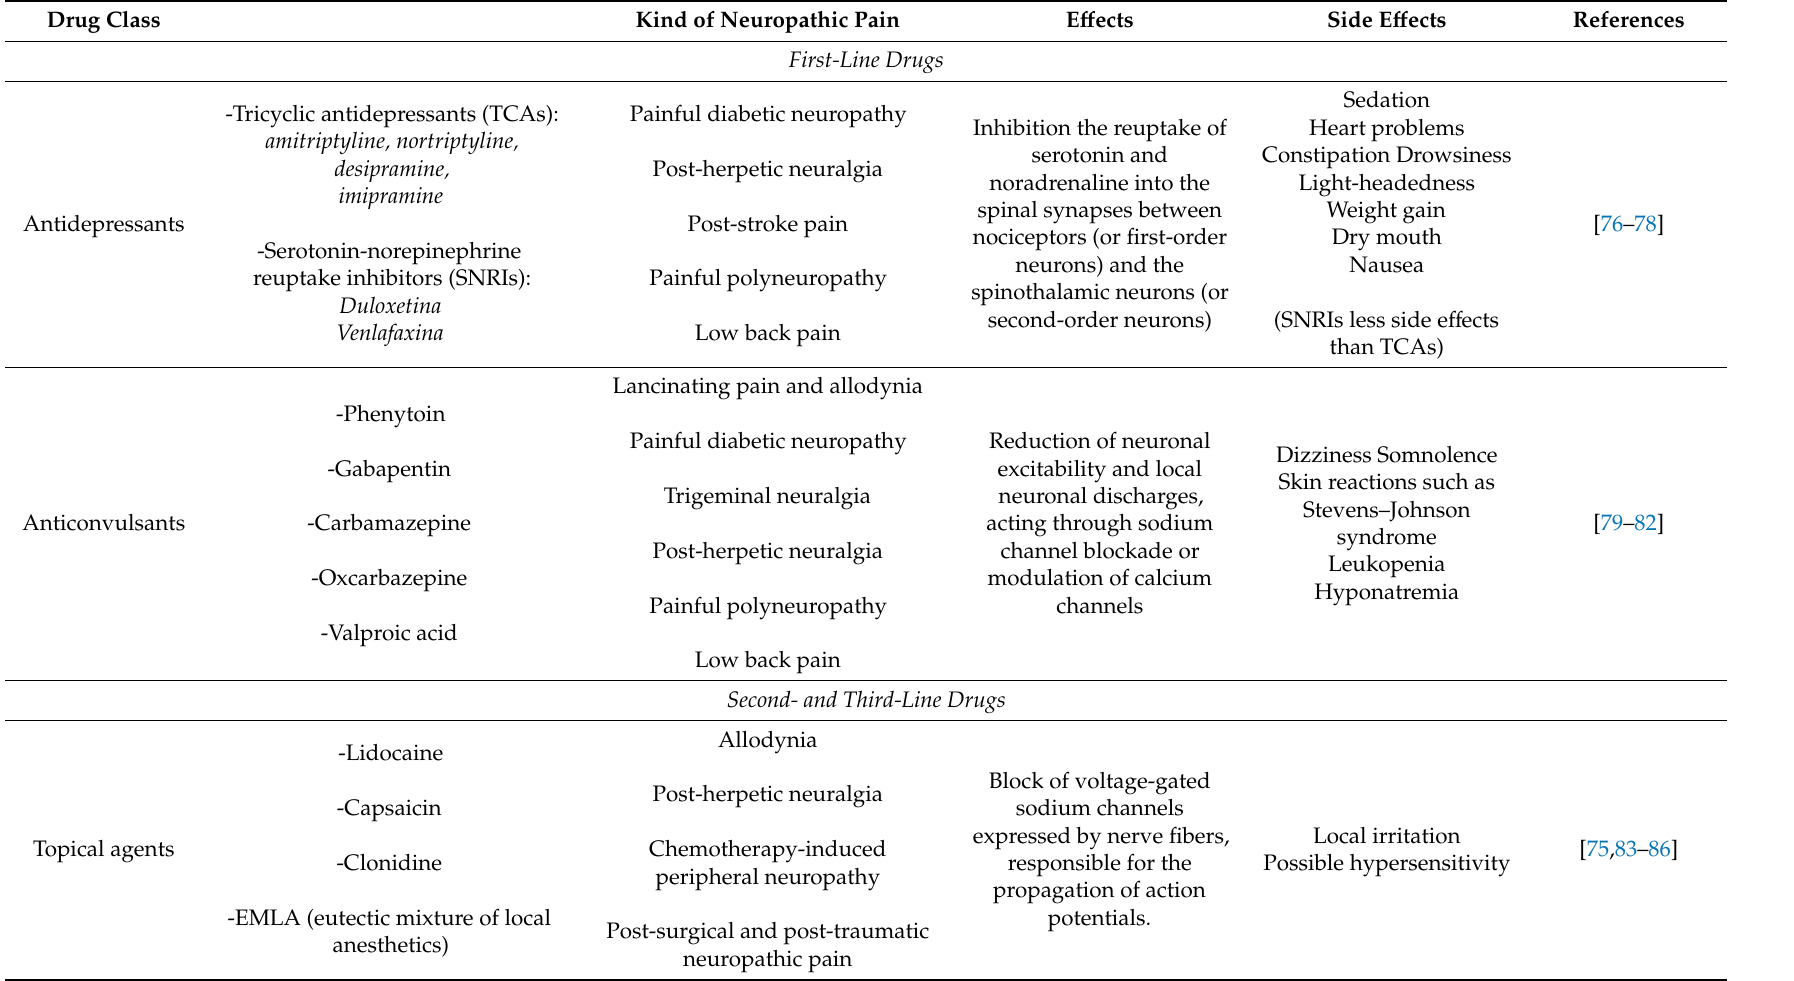
Table 5. Pharmacotherapies in use in neuropathic